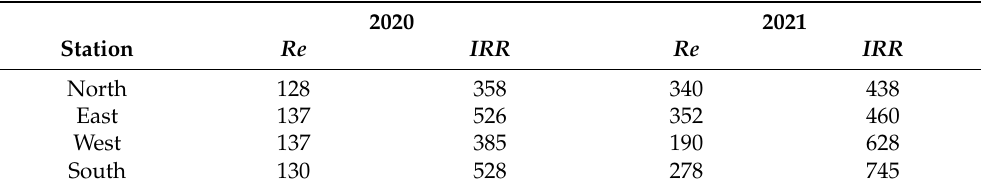
Table 2. Irrigation season total groundwater recharge ( Re ) and total irrigation ( IRR ) for each monitor- ing well location. All measurements are reported in